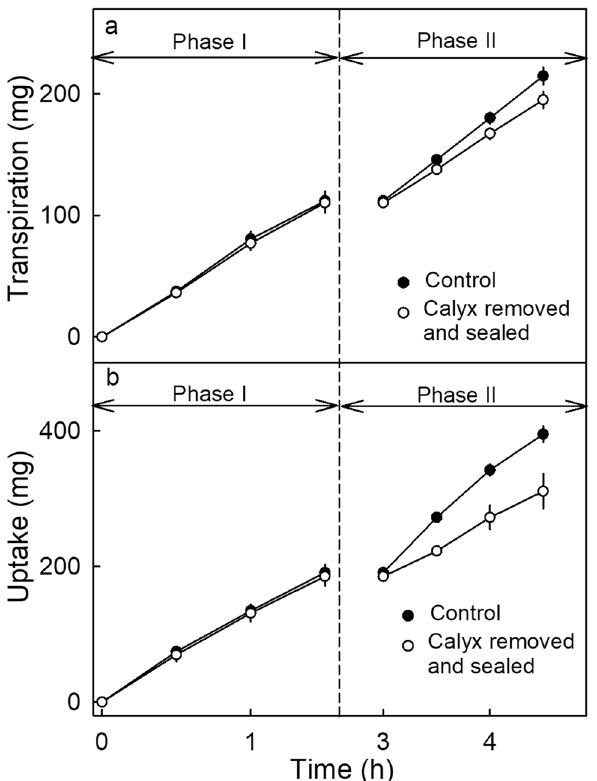
Figure 4. Effect of sealing selected regions of the surface of ripe strawberry cv. Sonsation on water movement in ( a ) transpiration or ( b ) water uptake. The experiment was conducted in two phases using a repeated measures design. During phase I (0 to 1.5 h), water movement was quantified in non-sealed fruit with calyx and 5 mm of the peduncle. For phase II (3–4.5 h), sepals and stamina were removed and the cut surface of the sepals, the abscission zones of the petals, the stamina, the junction calyx-receptacle, the peduncle surface including the peduncle end were all sealed (‘Calyx removed and sealed’). Fruit that remained without treatment during phase II served as control. For flow rates see Table. 1.